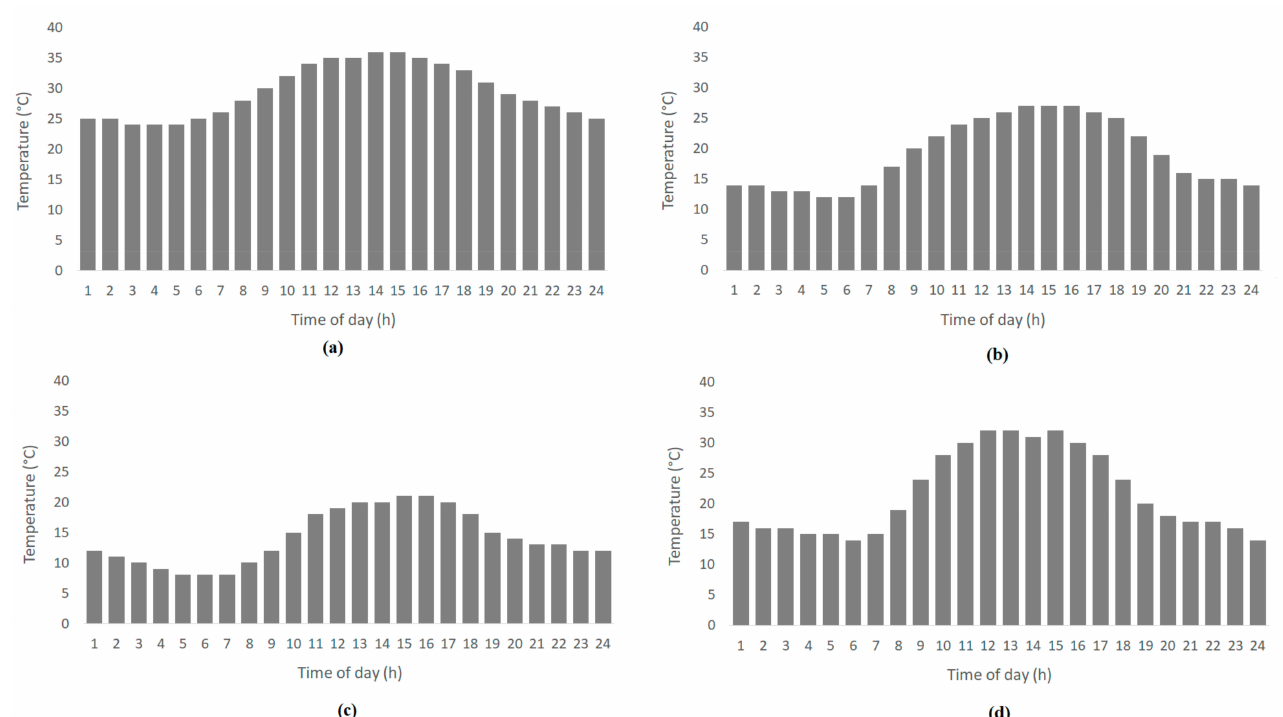
Figure 1. Temperature profile based on hourly variation during a one-day period to simulate the seasons: ( a ) summer, ( b ) autumn, ( c ) winter, ( d ) spring. They were determined based on the measurements published by AccuWeather (www.accuweather.com) for 2021. Latitude and longitude coordinates: 22 ◦ 54 (cid:48) 13 (cid:48)(cid:48) South; 43 ◦ 12 (cid:48) 35 (cid:48)(cid:48) West; Rio de Janeiro, Brazil, where a tropical monsoon climate ( Am ) has been reported (Köppen–Geiger climatic classification)